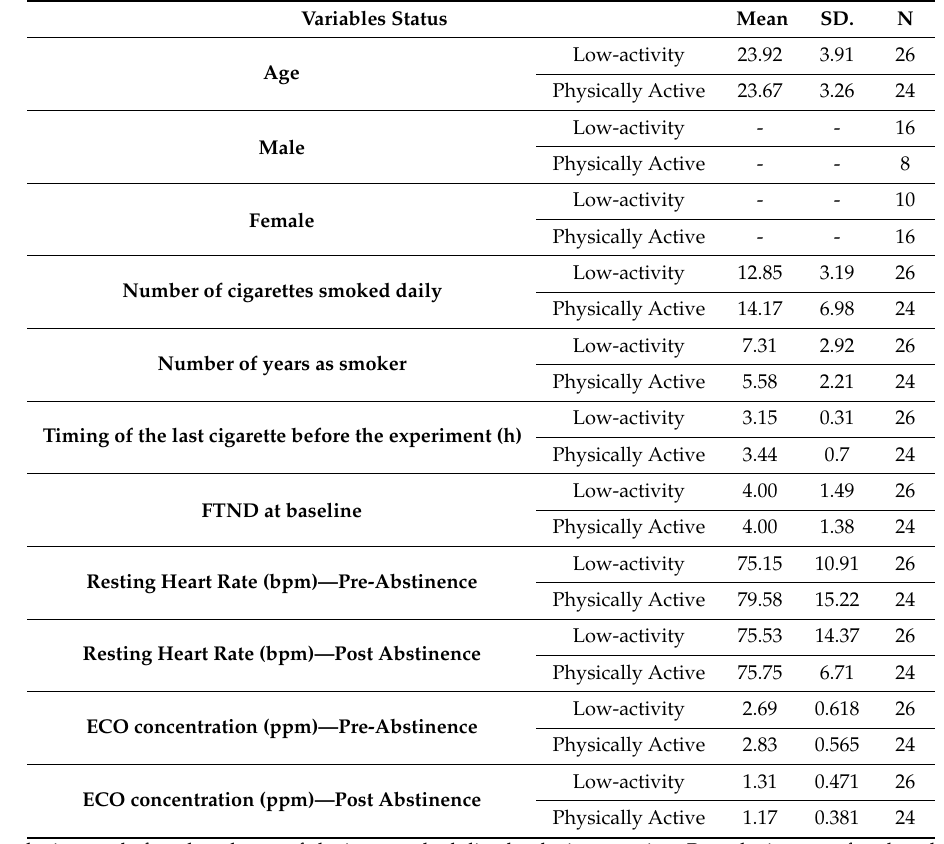
Table 1. Mean and standard deviation values for participants’ characteristics: age, numbers of cigarettes per day, numbers of years as smoker, Fagerstrom Test for Nicotine Dependence (FTND), expired carbon monoxide (ECO), and heart